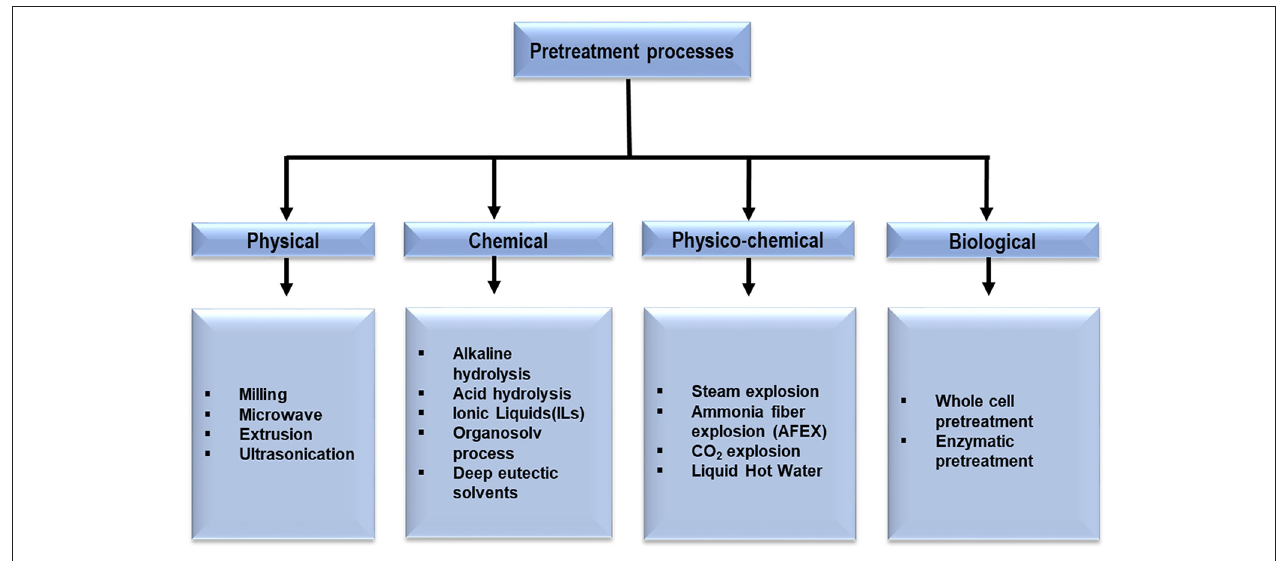
FIGURE 2 | Flow chart diagram of pretreatment